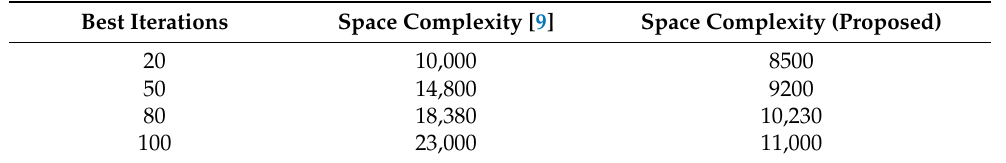
Figure 8. Comparison of memory requirements: FISA vs. traditional algorithms. Table 7. Comparison of storage